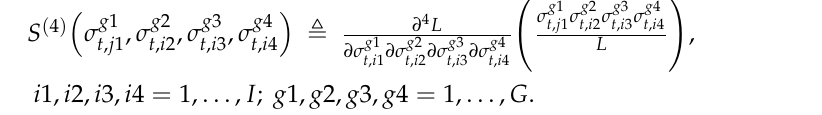
(cid:16) (cid:17) (cid:16) (cid:17) (cid:16) (cid:17) (cid:16) (cid:17) σ g σ g σ g σ g , S ( 2 ) , σ g , S ( 3 ) , σ g , σ g , S ( 4 ) , σ g , σ g , σ g , g = 1, . . . ,30, for isotope 1 t ,1 t ,1 t ,1 t ,1 t ,1 t ,1 t ,1 t ,1 t ,1 t ,1